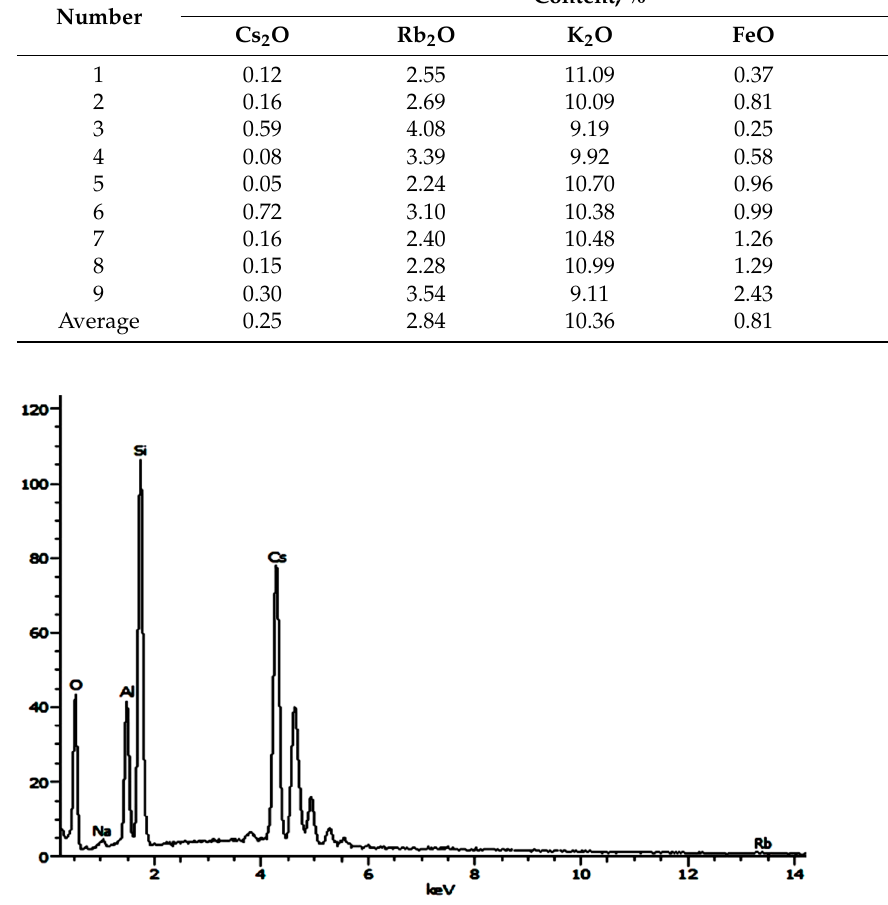
Figure 4. X-ray energy spectrum composition diagram for pollucite. Table 6. Energy spectrum micro-domain composition analysis for pollucite.